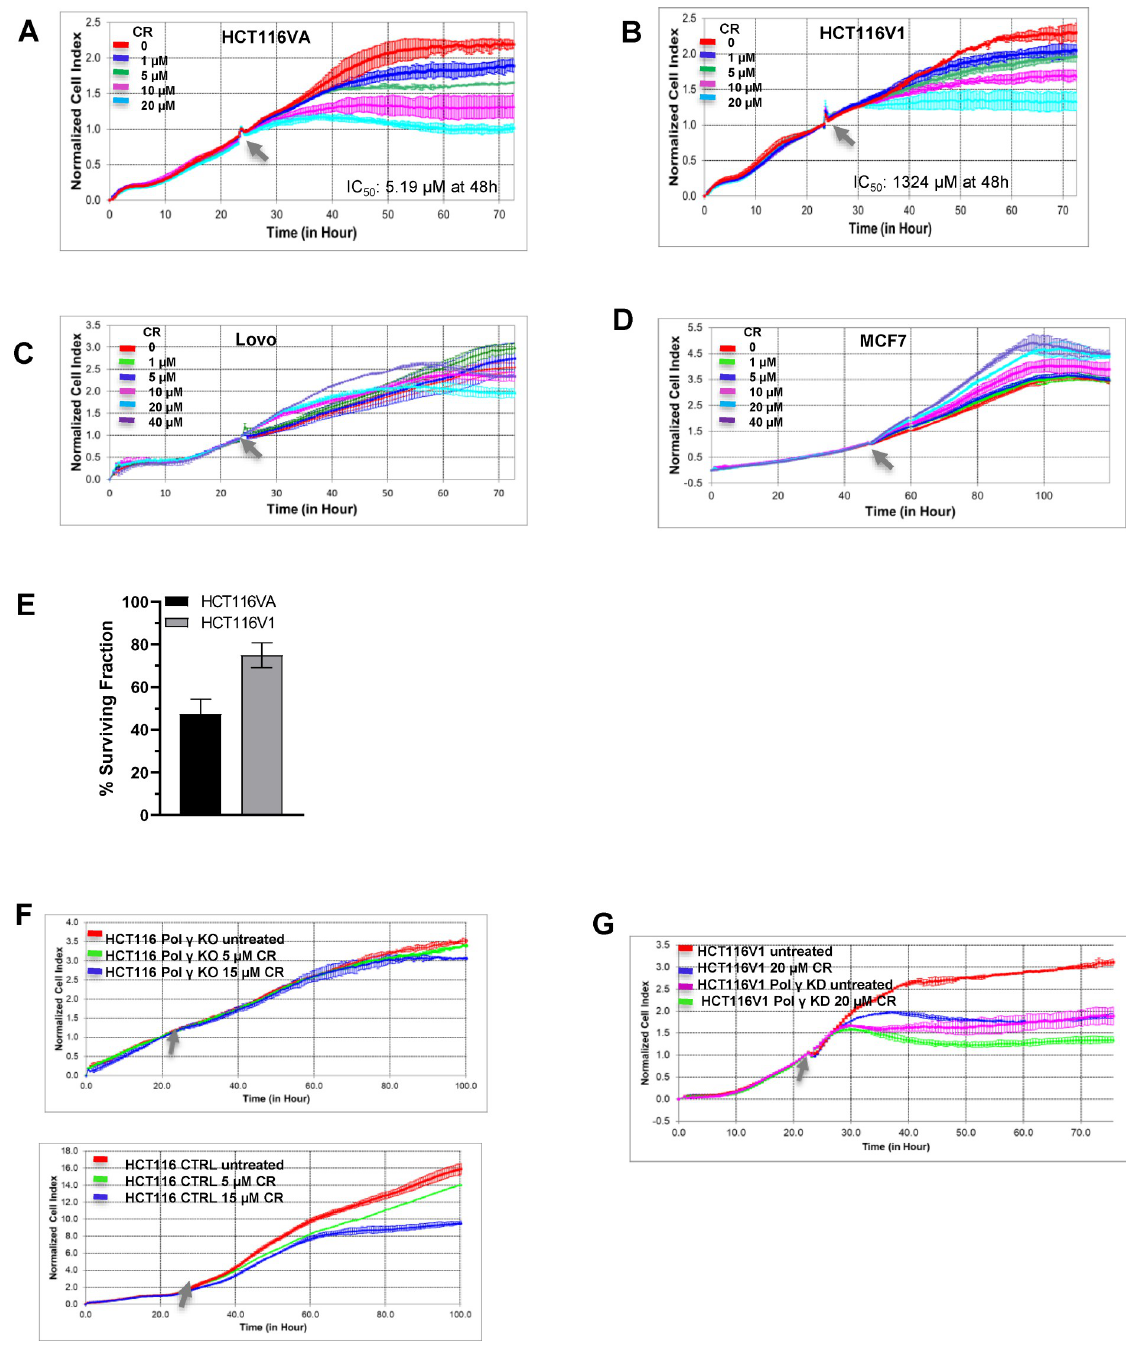
Fig 4. The effects of Pol γ inhibitor molecules on MLH1 deficient and proficient cancer cell proliferation. Real-time dynamic monitoring of the cytotoxic effects of CR on (A) HCT116VA (MLH1 deficient) (B) HCT116V1 (MLH1 proficient) (C) Lovo (MLH1 proficient) (D) MCF7 (MLH1 proficient) cells using the xCELLigence system. Cell growth was continuously monitored every 30 min. Cell index was normalized to the time point of CR administration. Normalized cell index was plotted as the mean value from triplicates; error bars represent the standard deviation of the mean. The Grey arrow indicates the time of CR administration. The xCELLigence RTCA software was used to determine IC 50 values at 48h post-treatment time point. (E) Effect of 5 μ M CR (IC 50 = 5.19 μ M) on colony formation in HCT116VA and HCT116V1 cells. Data are expressed as the mean ± standard deviation of three independent experiments. (F) Upper panel, Real-time dynamic monitoring of the cytotoxic effects of CR on CRISPR/Cas9 Pol γ knockout HCT116 cells and lower panel HCT116 control cells (empty vector control). (G) Real-time dynamic monitoring of the cytotoxic effects of CR on shRNA Pol γ knockdown HCT116V1 cells and HCT116V1 control